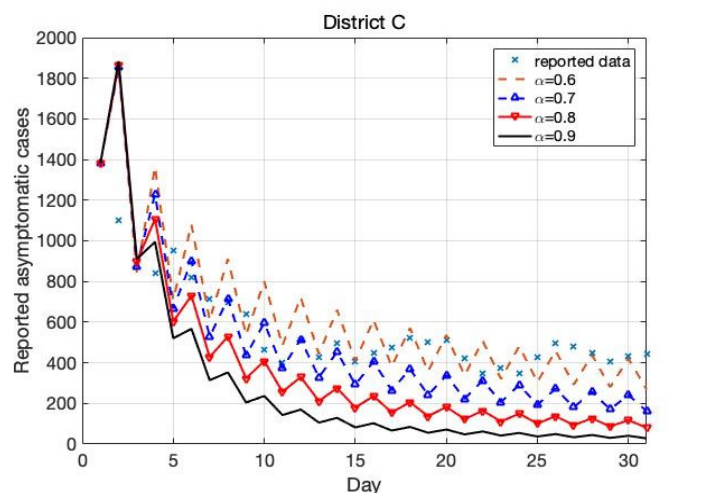
Figure 14. Model results for asymptomatic cases.